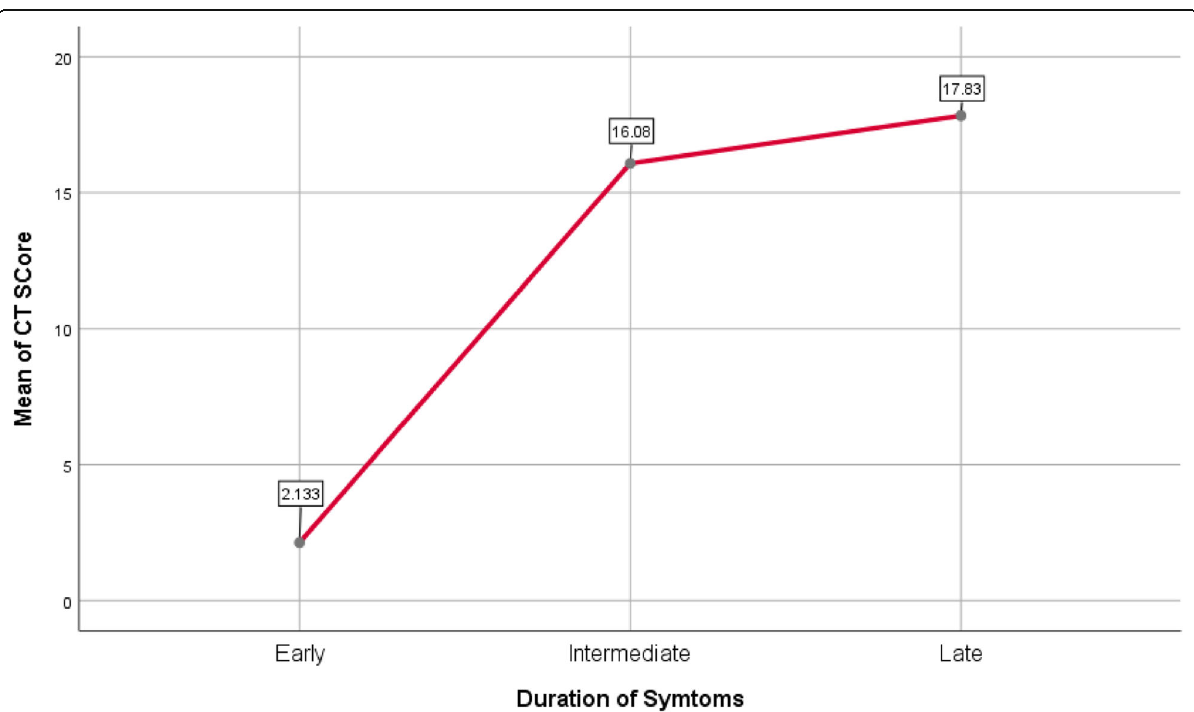
Fig. 2 Relation between CT severity score and duration of